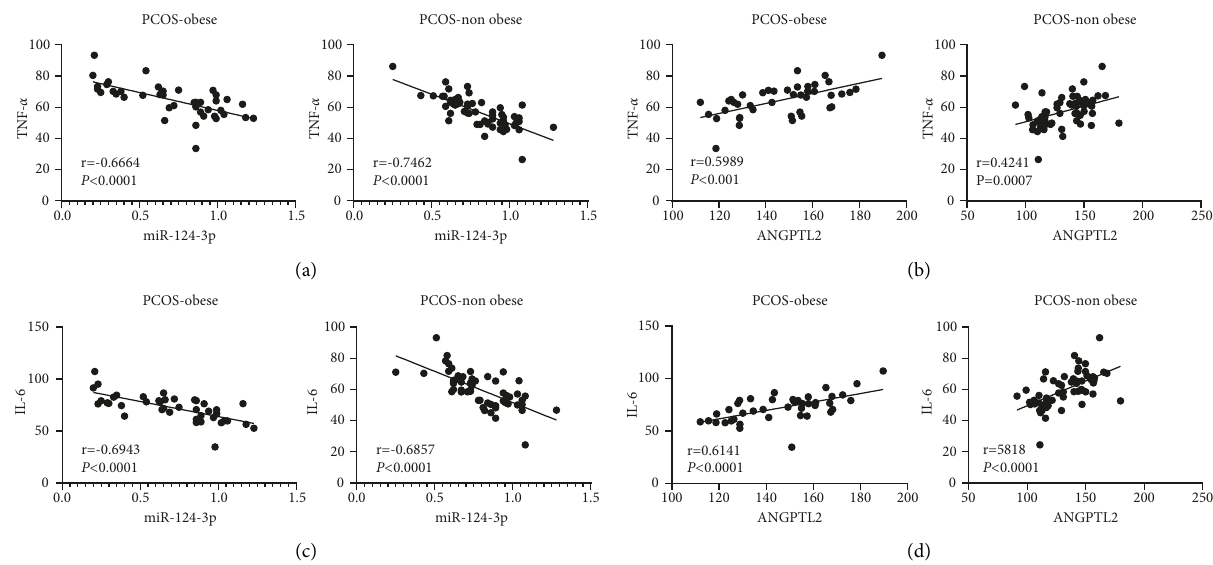
Figure 2: Correlation between serum miR-124-3p and ANGPTL2 with inflammatory factors in PCOS patients. (a–d) Correlation between serum miR-124-3p or ANGPTL2 level and TNF- α or IL-6 in PCOS patients. The correlation of data was carried out using Pearson correlation analysis.